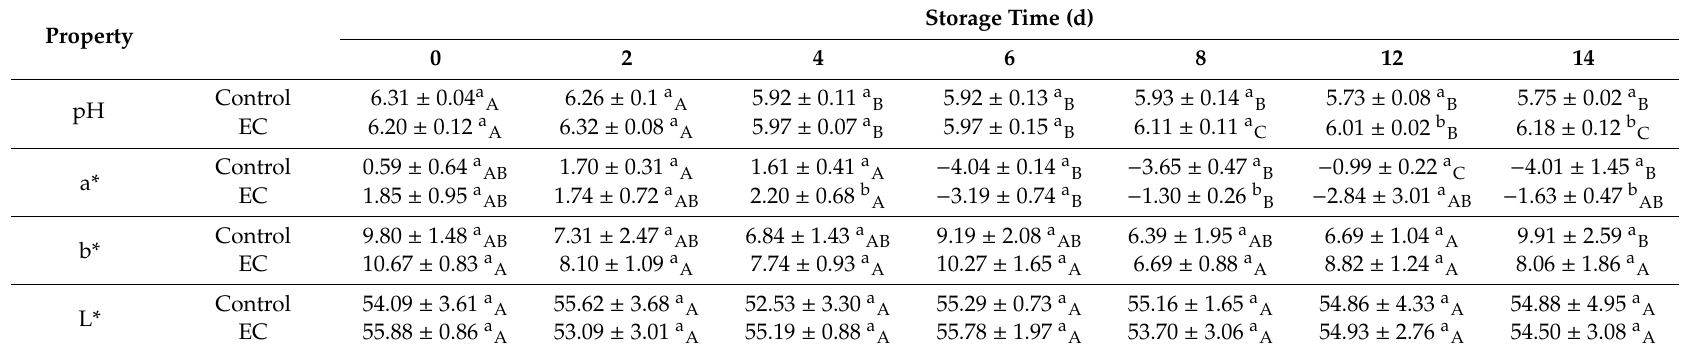
Table 3. Changes in pH and color coordinates of coated and control chicken breast fillets during storage at 5 ◦ C.